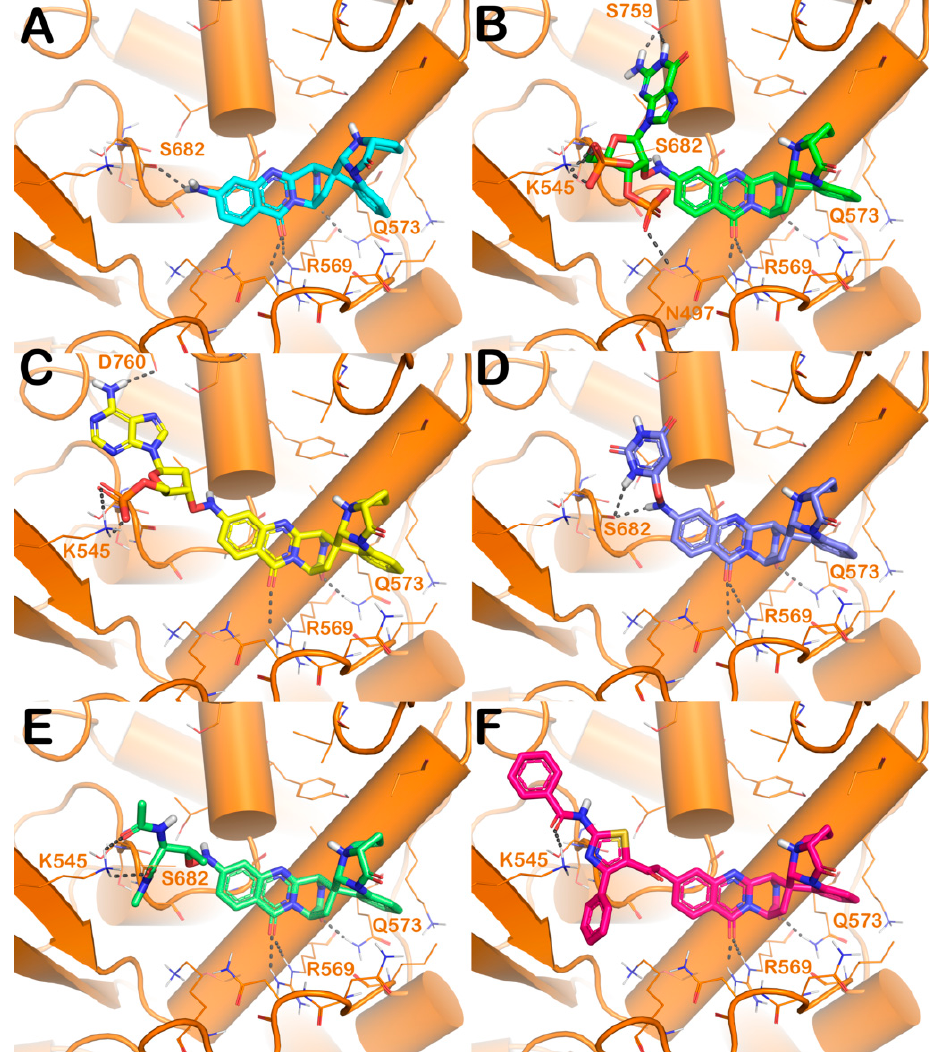
Figure 2. Putative binding mode of Q3 (cyan sticks, panel ( A )) and Q3 derivatives 1 – 5 (colored sticks, panel ( B – F ), respectively) within the SARS-CoV-2 binding site (PDB ID 6M71, orange cartoon). Interacting amino acids are represented by lines, while the H-bonds are indicated by grey-dotted lines. Pictures were generated by PyMOL (The PyMOL Molecular Graphics System, v1.8; Schrödinger, LLC, New York, NY, USA,